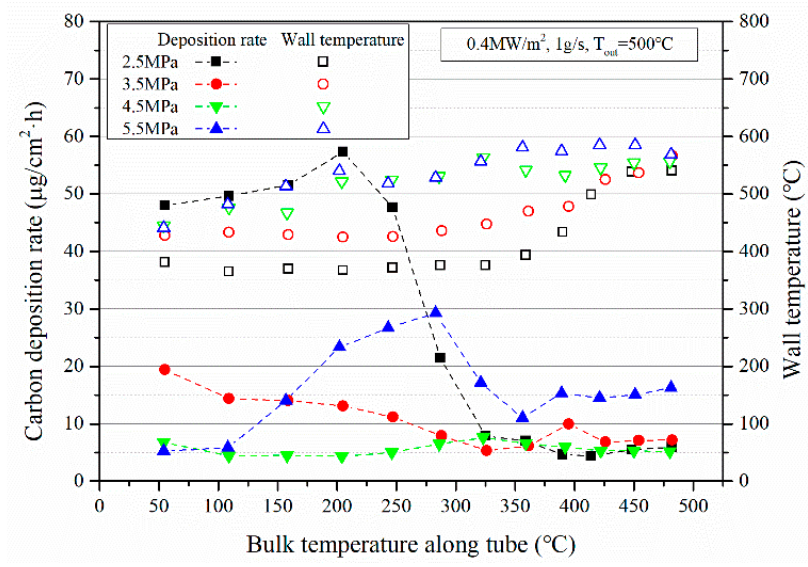
Figure 13. Temperature and deposition rate profiles at heat flux of 0.4 MW/m 2.